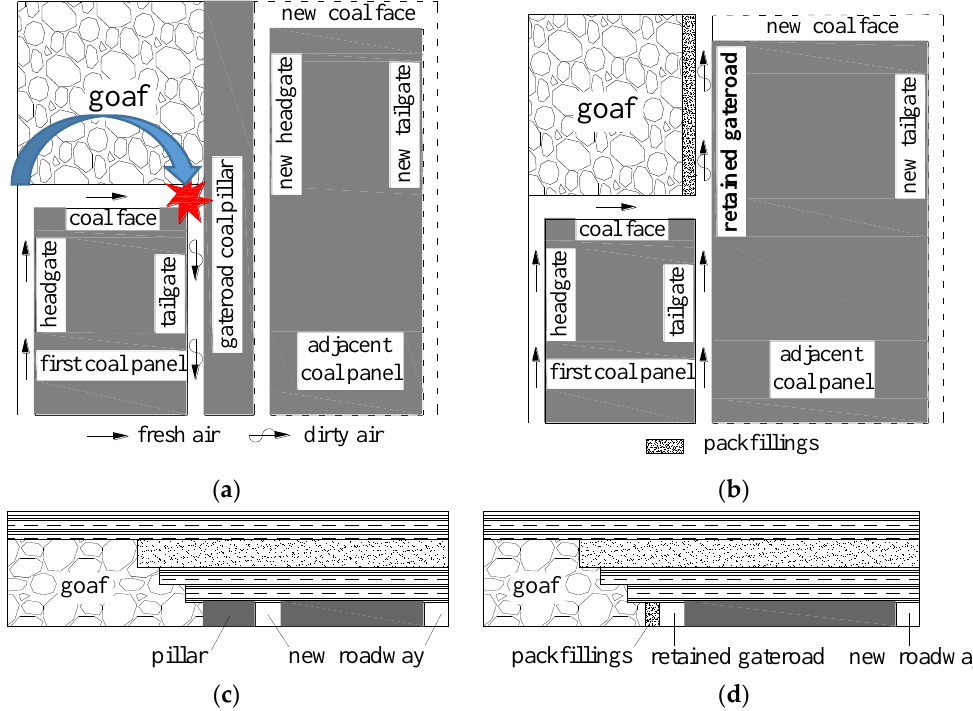
Figure 2. U type ventilation system ( a ); Y type ventilation system ( b ); Coal pillar reservation in U type settings ( c ); and Coal pillar reservation in Y type settings ( d ).